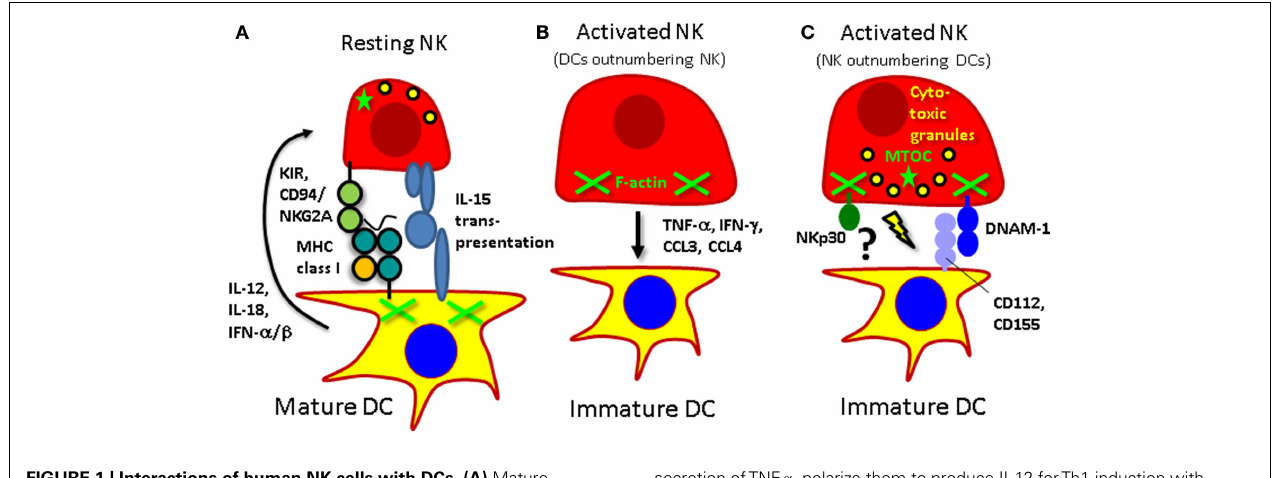
FIGURE 1 | Interactions of human NK cells with DCs . (A) Mature DCs activate resting NK cells via IL-12, IL-15, and type I IFN. At the same time NK cells receive an inhibitory signal via killer immunoglobulin-like receptors (KIRs) or CD94/NKG2A to prevent them from killing mature DCs. (B) Activated NK cells can mature DCs via